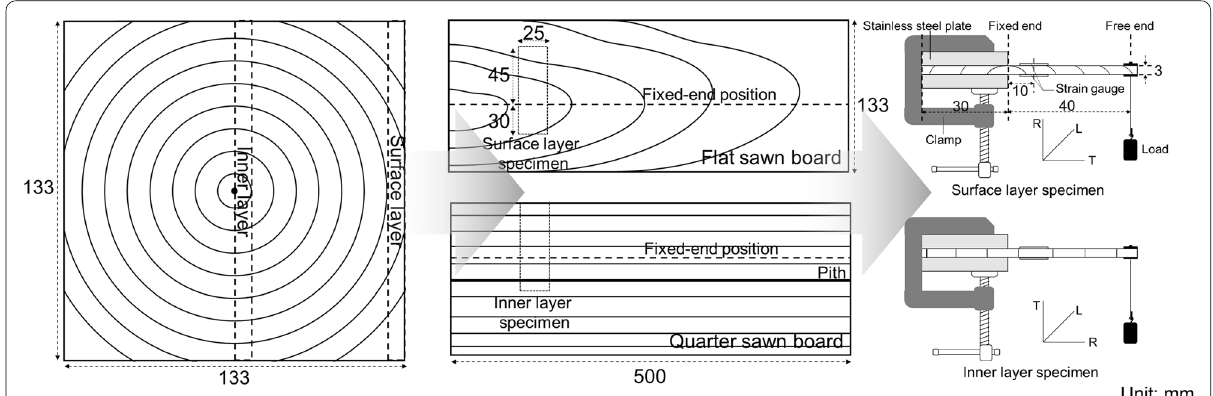
Fig. 1 Schematic diagram showing preparation of the specimens and the cantilever fixed-end position